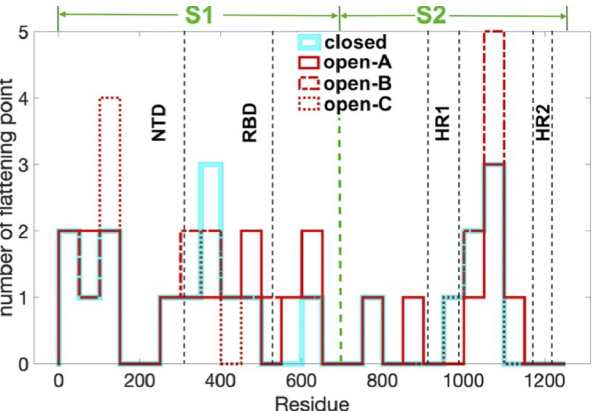
Fig 4. The histogram shows the distribution of sites that are proximal to a flattening point along the spike protein backbone, in blocks of 40 sites. The proximal sites accumulate in the NTD and RBD domains, and in the fusion core between the HR1 and HR2 domains. The PDB structures are 6VXX for closed state and 6VYB for open state.